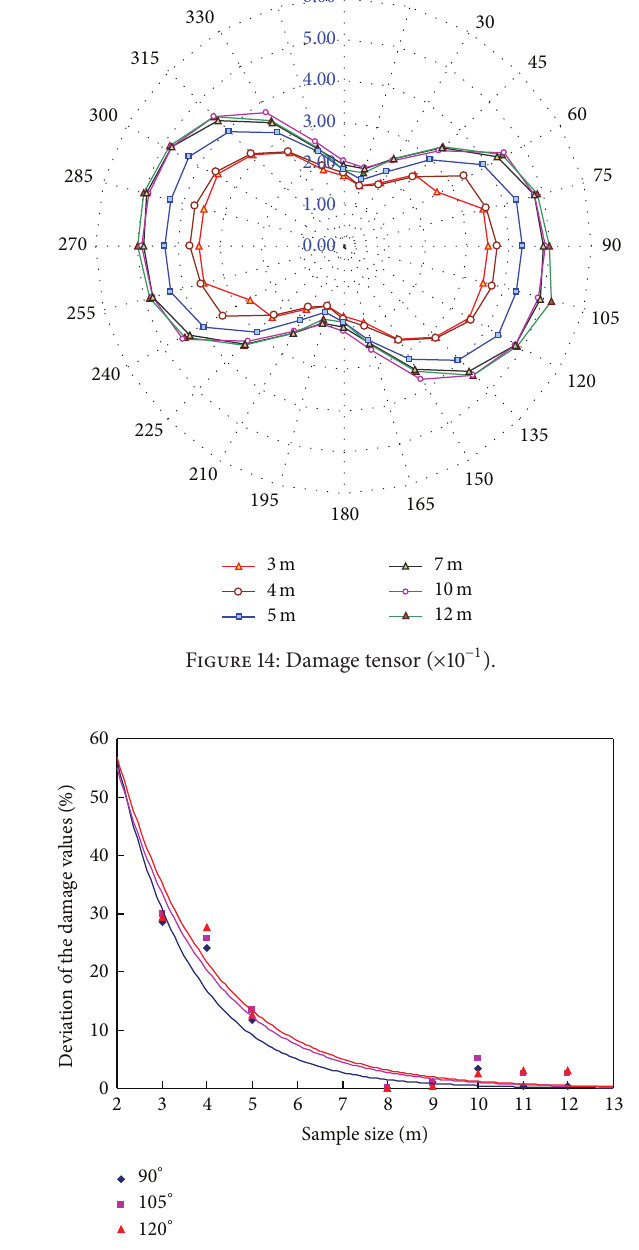
𝐸 𝑖𝑗 , and shear modulus